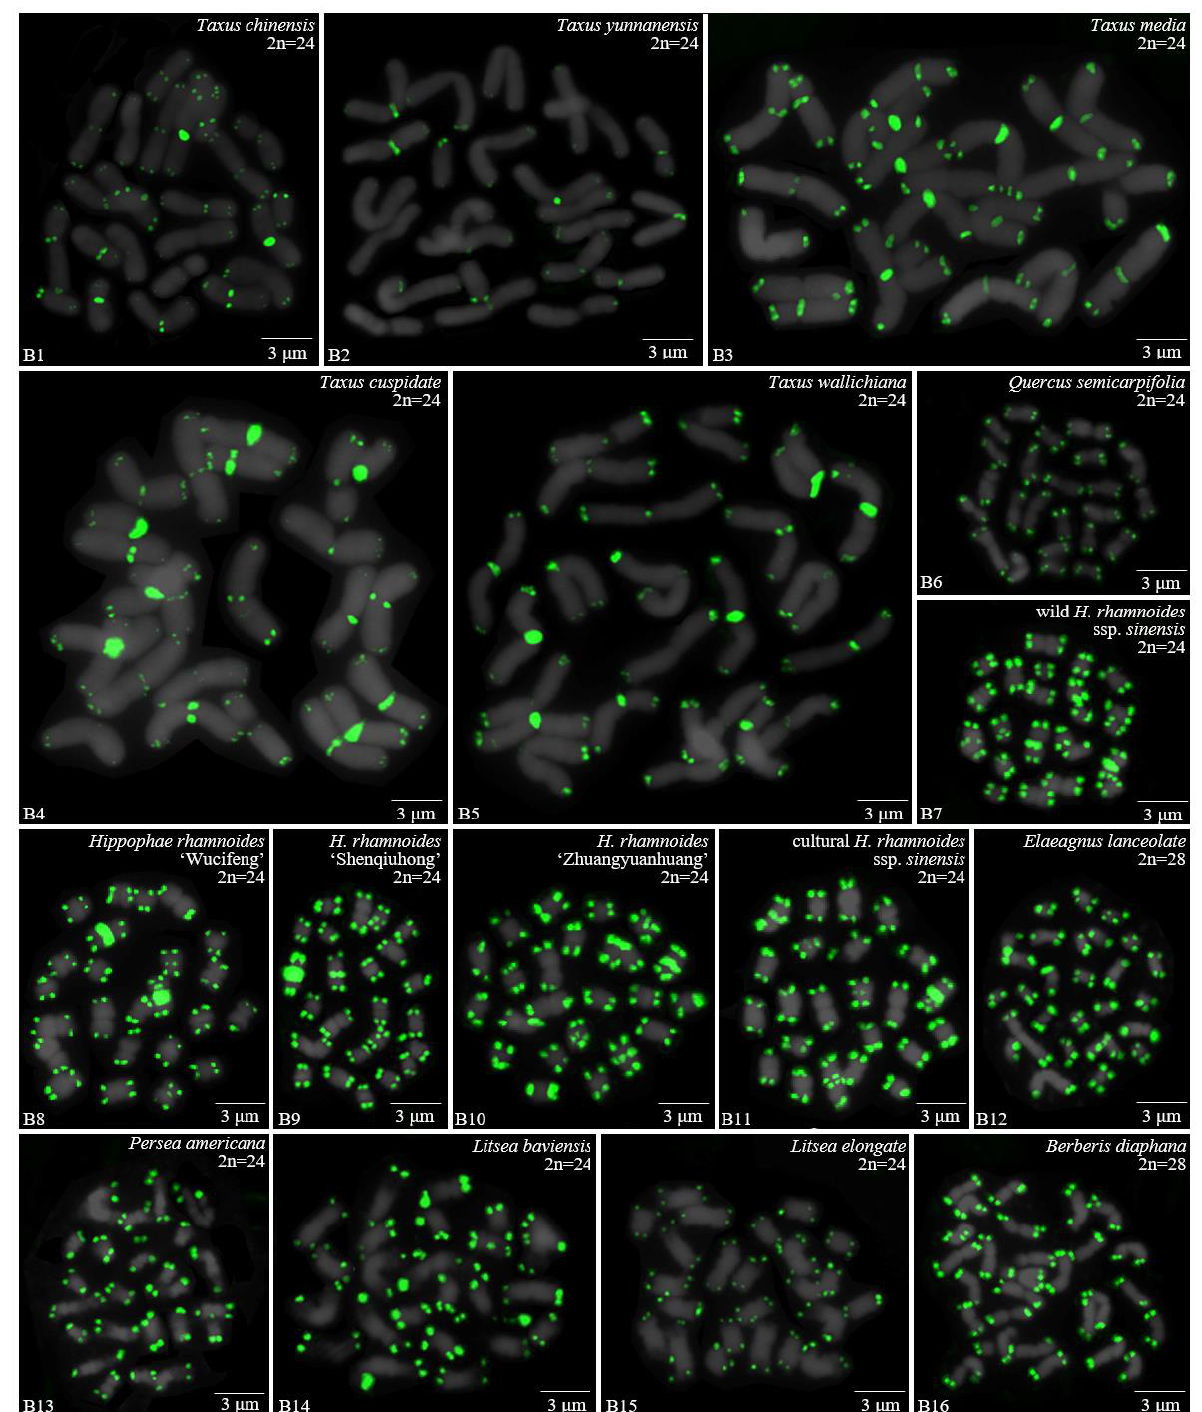
Figure 2. Oligo-FISH depicting the (AG 3 T 3 ) 3 present in 16 woody plants. All chromosomes in B1–B16 are from metaphase. Oligo-probe (AG 3 T 3 ) 3 is exhibited by green signals: ( B1 ) T. chinensis , 2n = 24; ( B2 ) T. yunnanensis , 2n = 24; ( B3 ) T. media , 2n = 24; ( B4 ) T. cuspidata , 2n = 24; ( B5 ) T. wallichiana , 2n = 24; ( B6 ) Q. semecarpifolia , 2n = 24; ( B7 ) wild H. rhamnoides ssp. sinensis , 2n = 24; ( B8 ) H. rhamnoides ‘Wucifeng’, 2n = 24; ( B9 ) H. rhamnoides ‘Shenqiuhong’, 2n = 24; ( B10 ) H. rhamnoides ‘Zhuangyuanhuang’, 2n = 24; ( B11 ) cultural H. rhamnoides ssp. sinensis , 2n = 24; ( B12 ) E. lanceolata , 2n = 28; ( B13 ) P. americana , 2n = 24; ( B14 ) L. baviensis , 2n = 24; ( B15 ) L. elongate , 2n = 24; and ( B16 ) B. diaphana , 2n = 28. Bar: 3 μm.